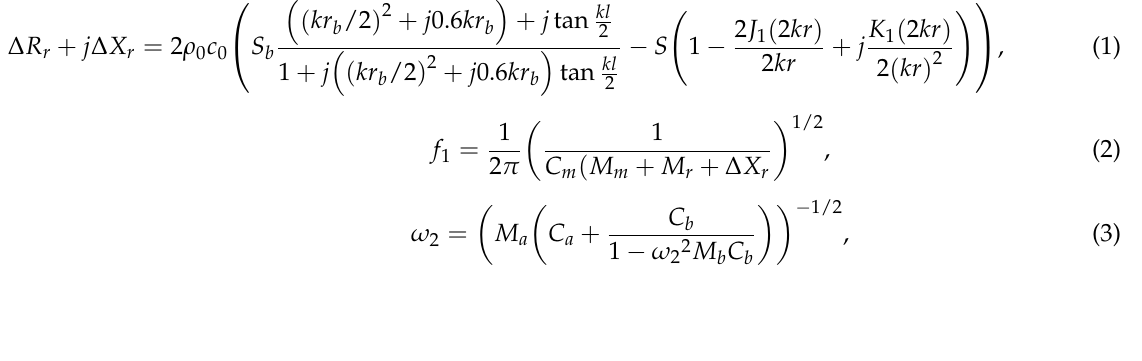
Figure 2. Equivalent circuit.